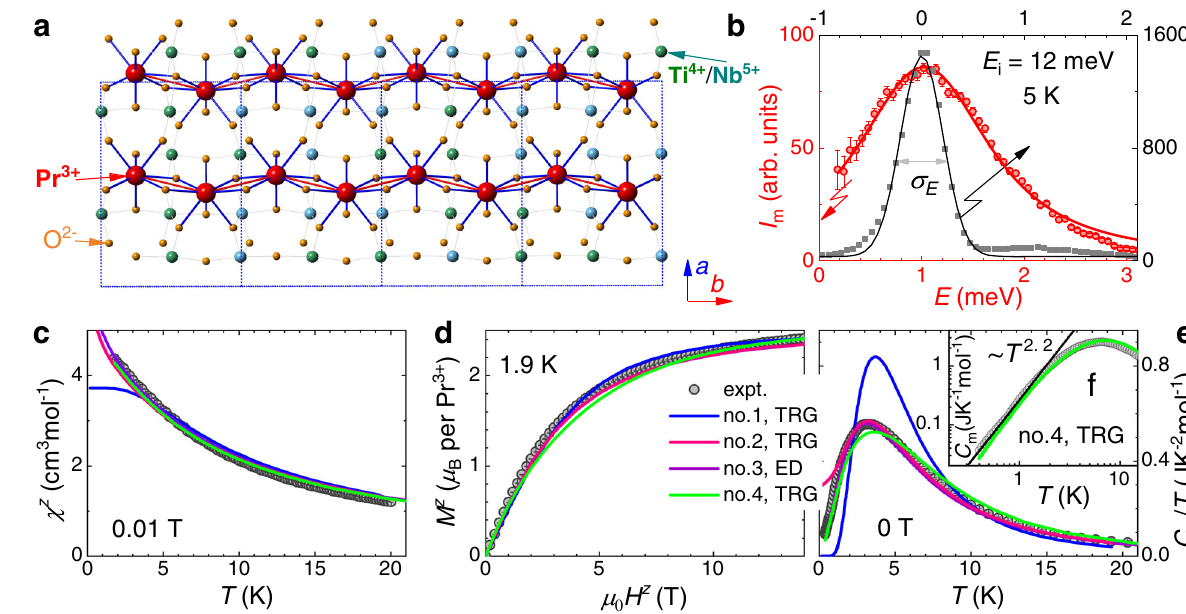
Fig. 1 Crystal structure, CEF splitting, and thermodynamic fi ttings of PrTiNbO 6 . a Crystal structure of PrTiNbO 6 viewed in the ab plane, where the dashed blue lines indicate the unit cells. b Magnetic INS data (red), where the elastic and lattice INS contribution measured on the nonmagnetic reference compound, LaTiNbO 6 , has been subtracted. The gray squares present the total intensity of PrTiNbO 6 . The gray line shows the Gaussian fi t to the elastic signal with the fi tted resolution of σ E = 0.48(1) meV, whereas the red line presents the fi t to the magnetic data with the convolution function (see main text). c − e Combined fi ts to measured thermodynamic data 31 using models no.1 (without randomness) and 2 – 4 (random Ising chain with similar parameters, see main text). f Power-law temperature dependence of the magnetic heat capacity below ∼ 2 K measured at zero fi eld, as compared to the green line calculated by model no. 4. The lattice heat capacity measured on LaTiNbO 6 has been subtracted in ( e , f ) 31 . Error bars on the experimental data points show a standard